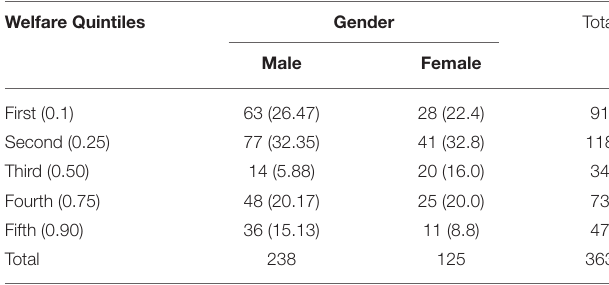
TABLE 2 | Cross-tabulation of Gender and Welfare